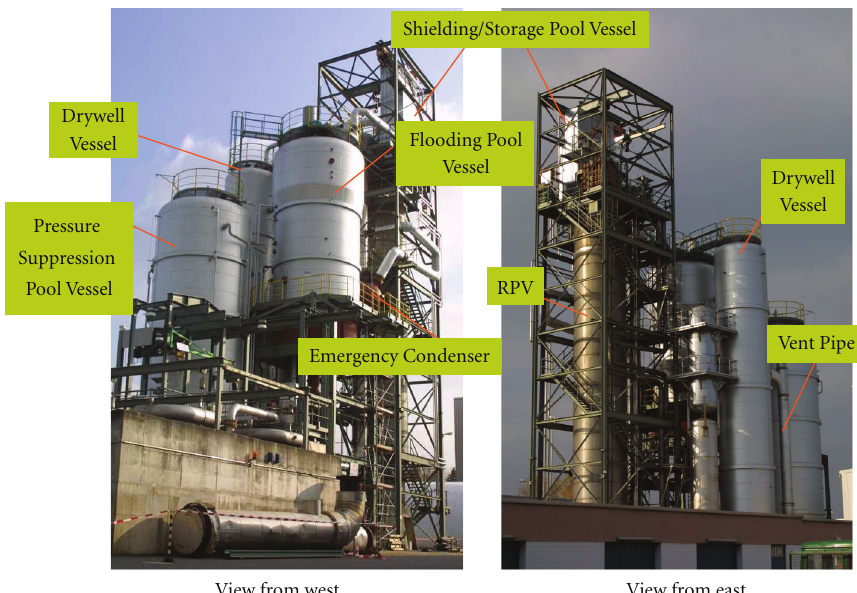
Figure 5: Picture of the INKA Test Facility from two di ff erent views.